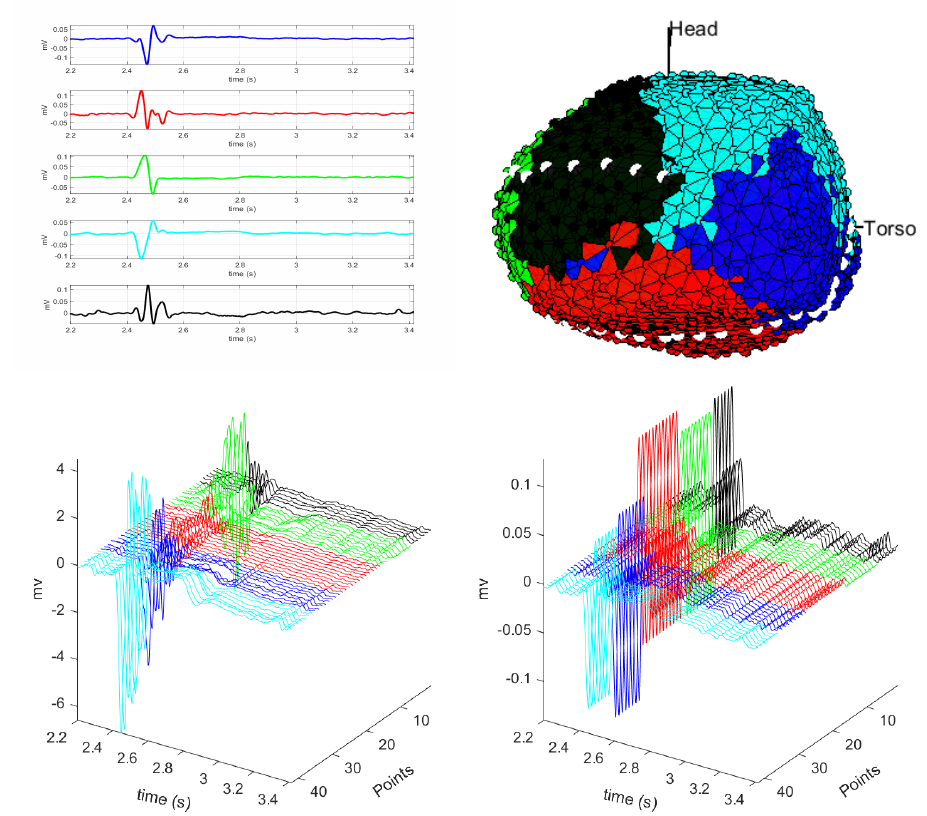
Figure 6. The cosine distance method with K = 5. The upper left panel shows the centroids of each class and the right one, the clustering map. The lower left panel shows the M-mode of the bipolar EGMs of each region where the dotted line passes, and right one, depicts the M-mode of the centroids of the same